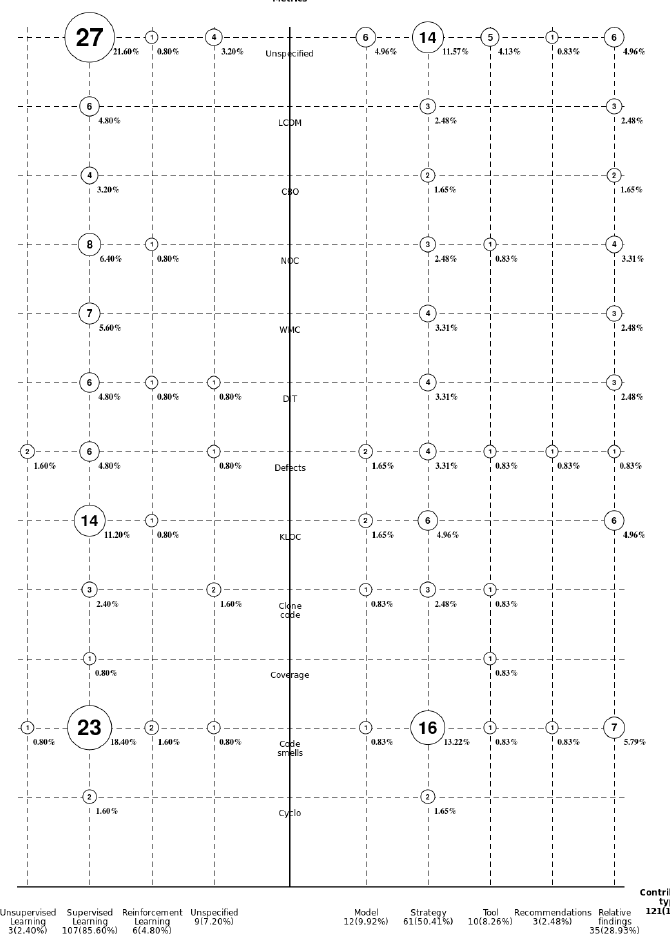
Figure 18. Distribution of studies by type of ML algorithm, software metrics, and type of